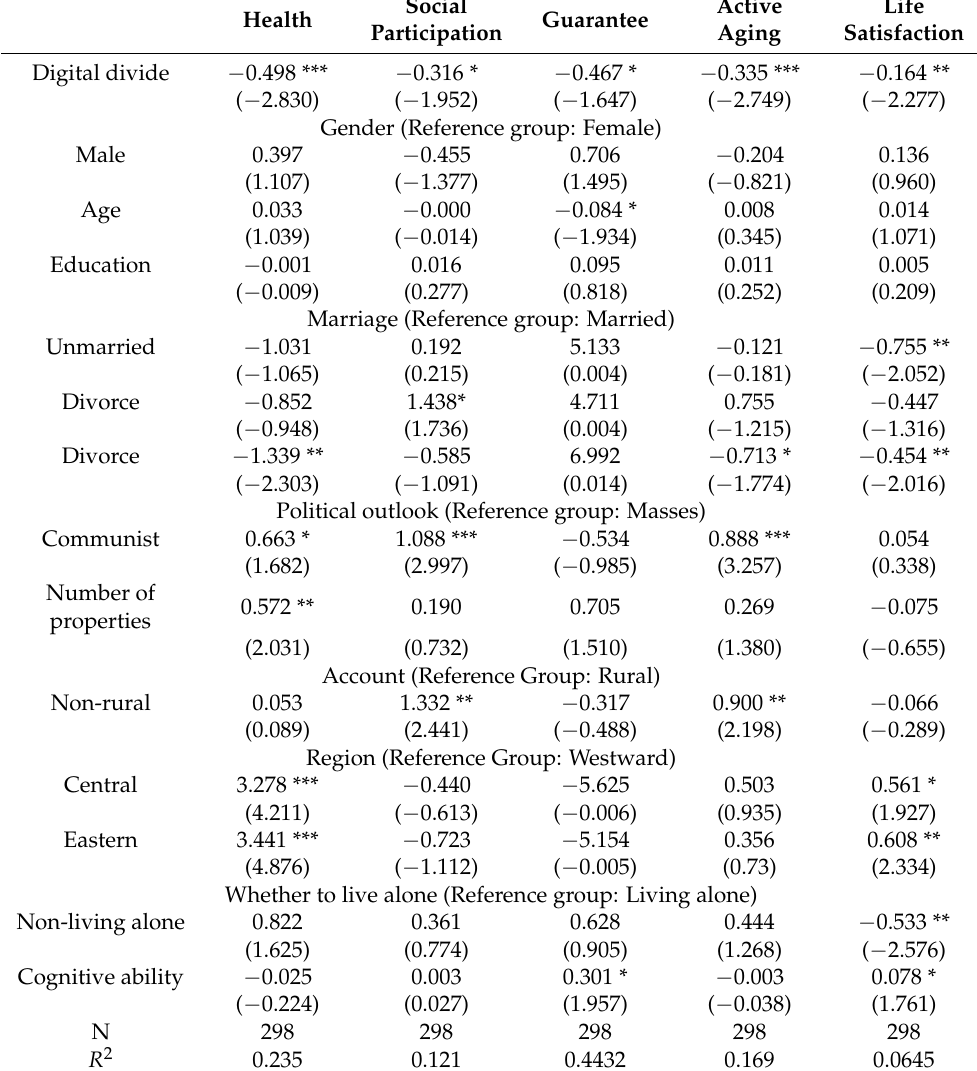
Table 2. Linear regression results of indicators such as the digital divide of the elderly and active aging of the